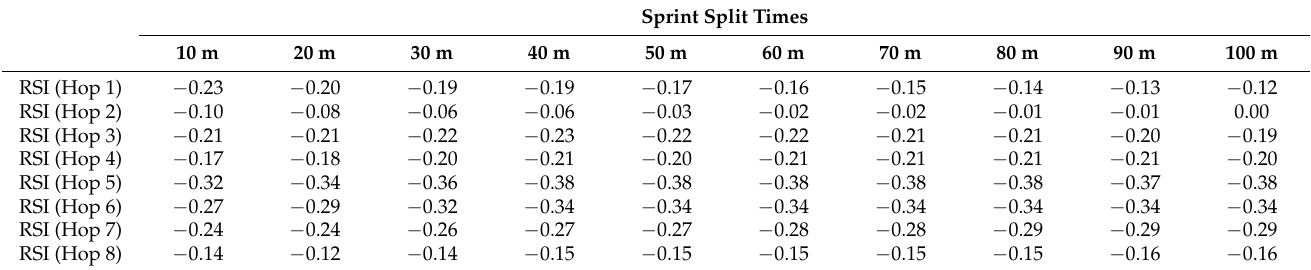
Figure 2. Contact time, flight time, and reactive strength index throughout the first 8 steps in the sprint task. Table 2. Association between the hop-RSI metrics (8 hops) and sprint split times (100 m with 10 m